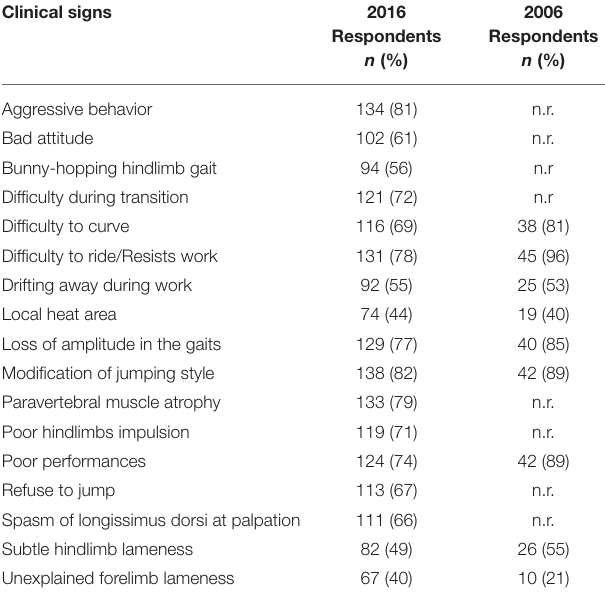
TABLE 3 | Clinical signs considered by respondents in 2006 and 2016 suggestive of back-pain in horses. Clinical